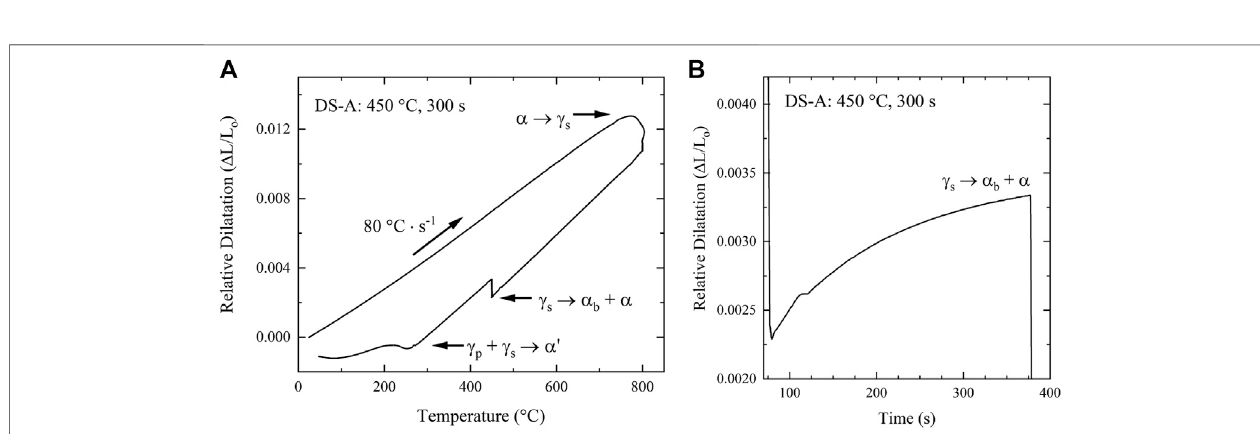
FIGURE 4 | (A) Relative dilatation vs. temperature and (B) relative dilatation vs. time for the DS-A: 450 ° C, 300 s heat treatment. Phase transformations associated with each feature of the dilatometric data are indicated as: ferrite ( α ), primary austenite ( c P ), secondary austenite ( c s ), martensite ( α ′ ) and bainitic ferrite ( α b ).